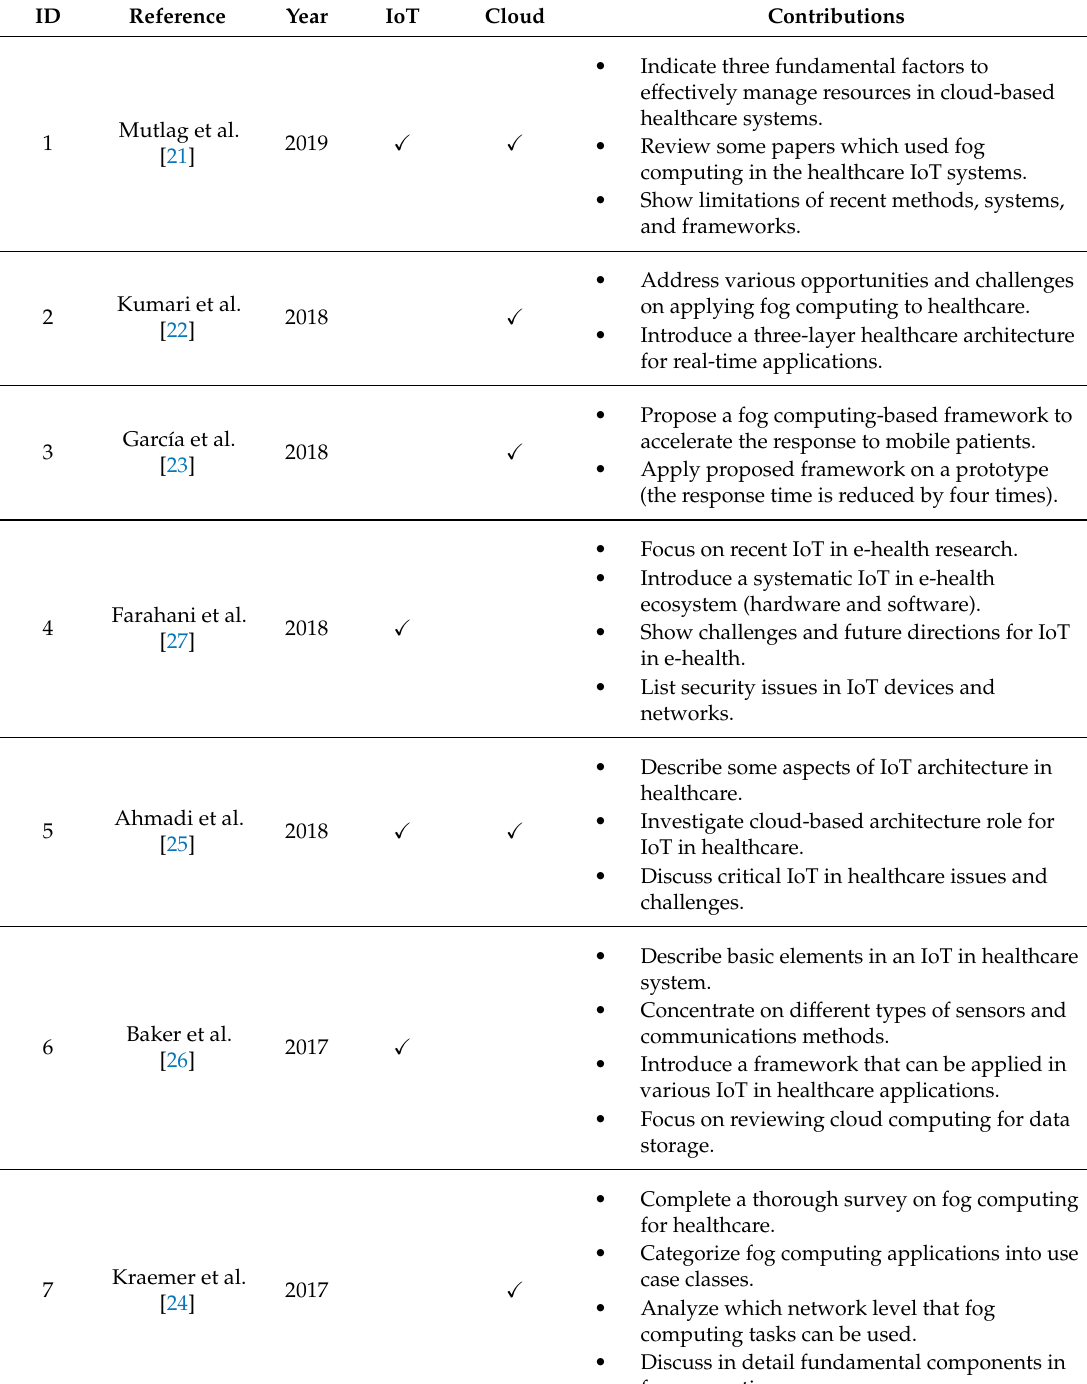
Table 1. List of contributions from previous surveys on cloud computing and IoT in